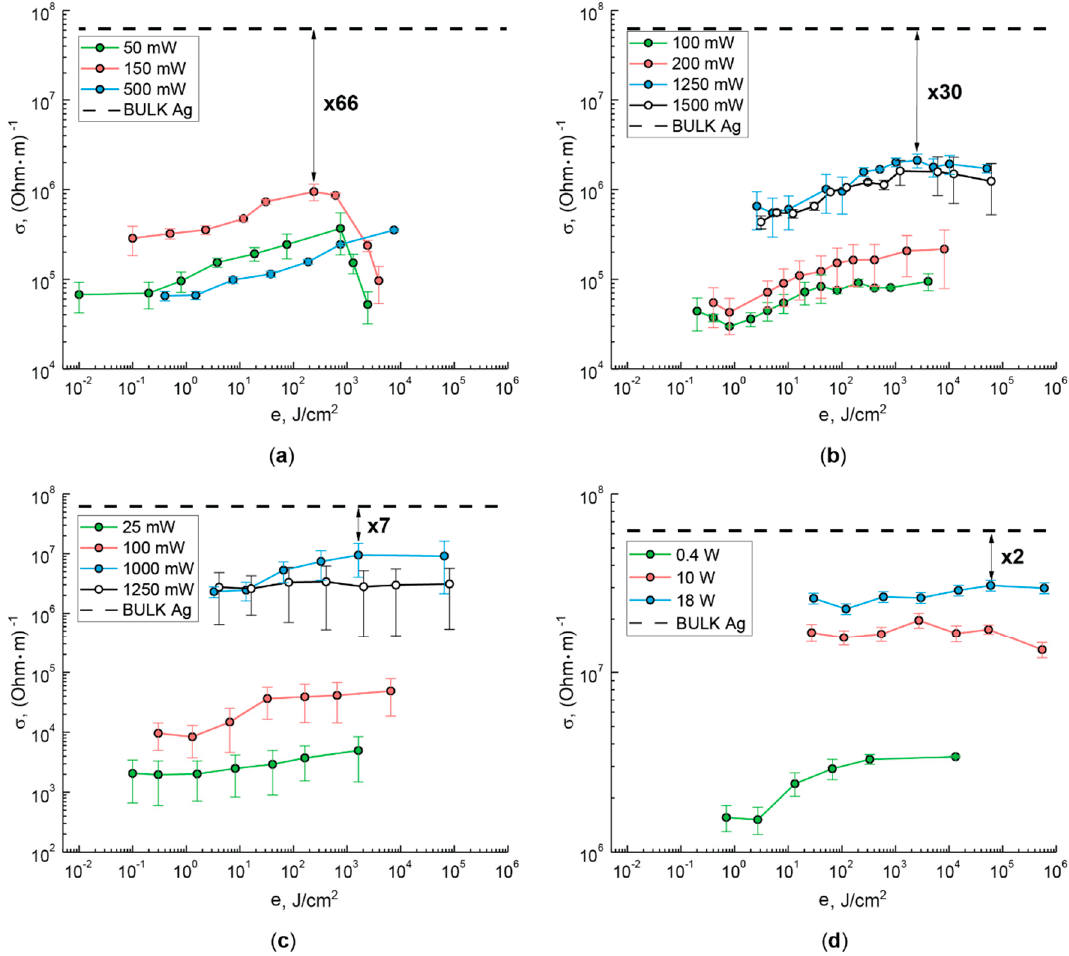
Figure 4. The dependence of the specific electrical conductivity σ of sintered NP arrays versus the specific energy supplied to the sample e for pulsed laser radiation with wavelengths ( a ) 527 nm, ( b ) 1054 nm and continuous laser radiation with wavelengths ( c ) 527 nm, ( d ) 980 nm at different values of their average power.